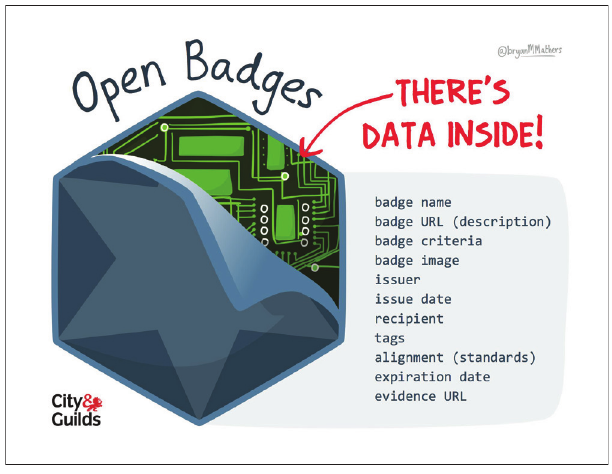
FIGURE 6: Open Badges anatomy – Badge metadata.